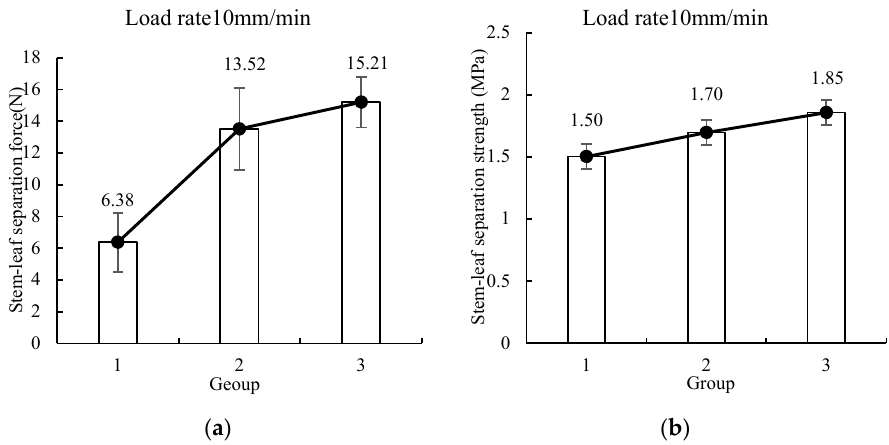
Figure 23. Wakame stem–leaf separation force and strength under different thickness. ( a ) wakame stem–leaf separation force under different thickness; ( b ) wakame stem–leaf separation strength under different thickness.